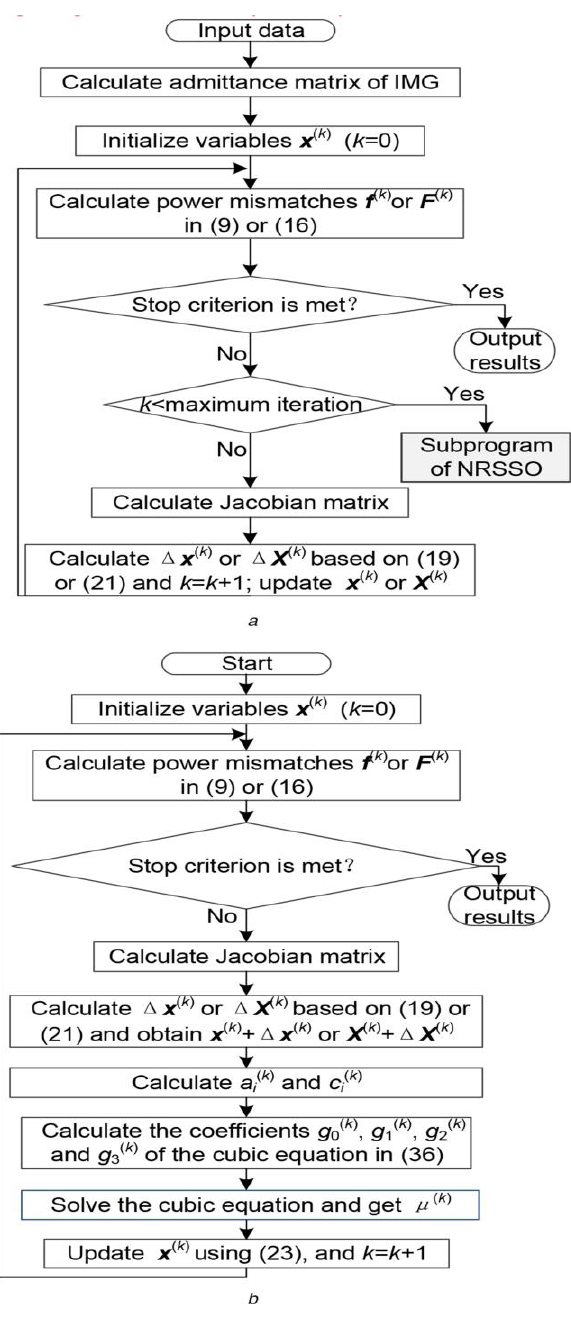
Figure 13. Flowchart of the proposed flow calculation